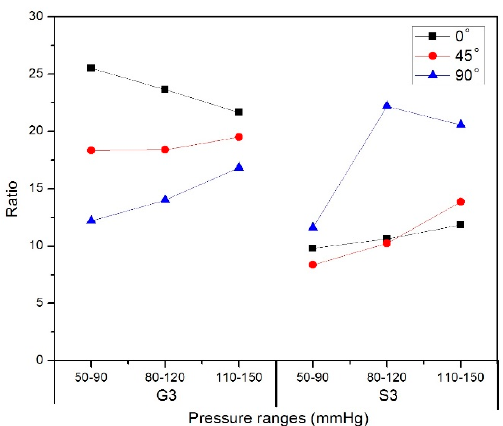
Figure 14. The ratio of diameter change between nitinol-PU and nitinol-PET stent grafts in unstented zone G3 and stented zone S3.